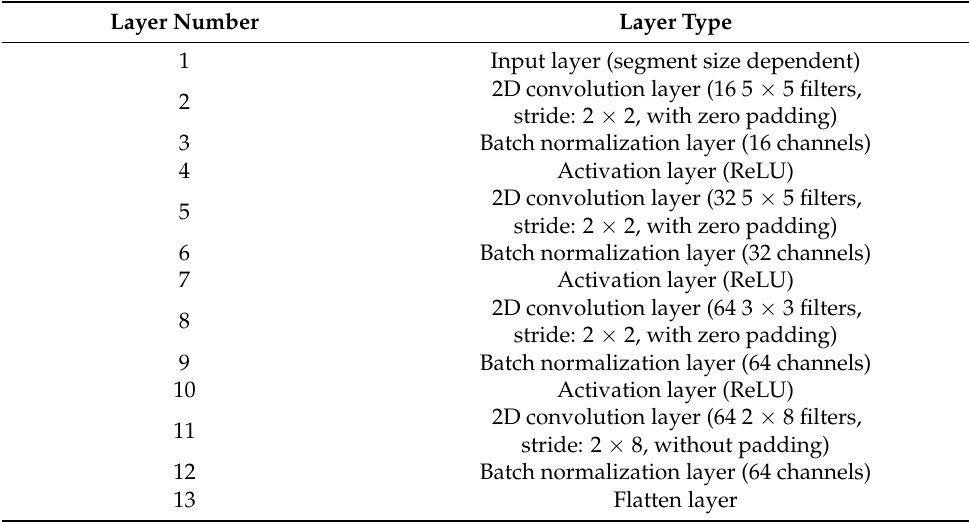
Table 3. CNN1 network structure.